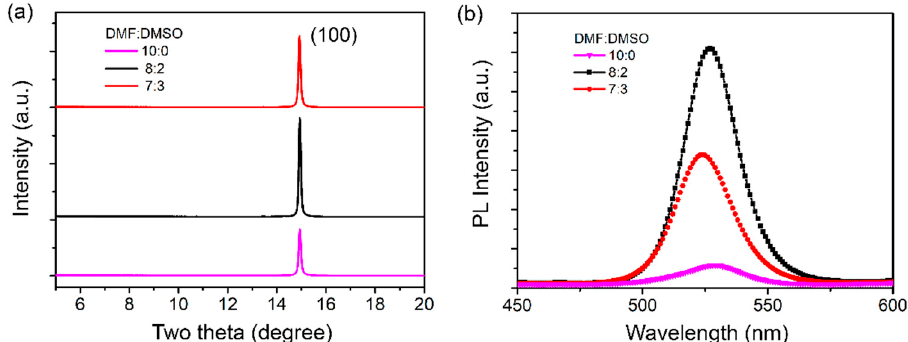
Figure 2. XRD patterns ( a ) and PL spectra ( b ) of the CH 3 NH 3 PbBr 3 films with different ratios of precursors.